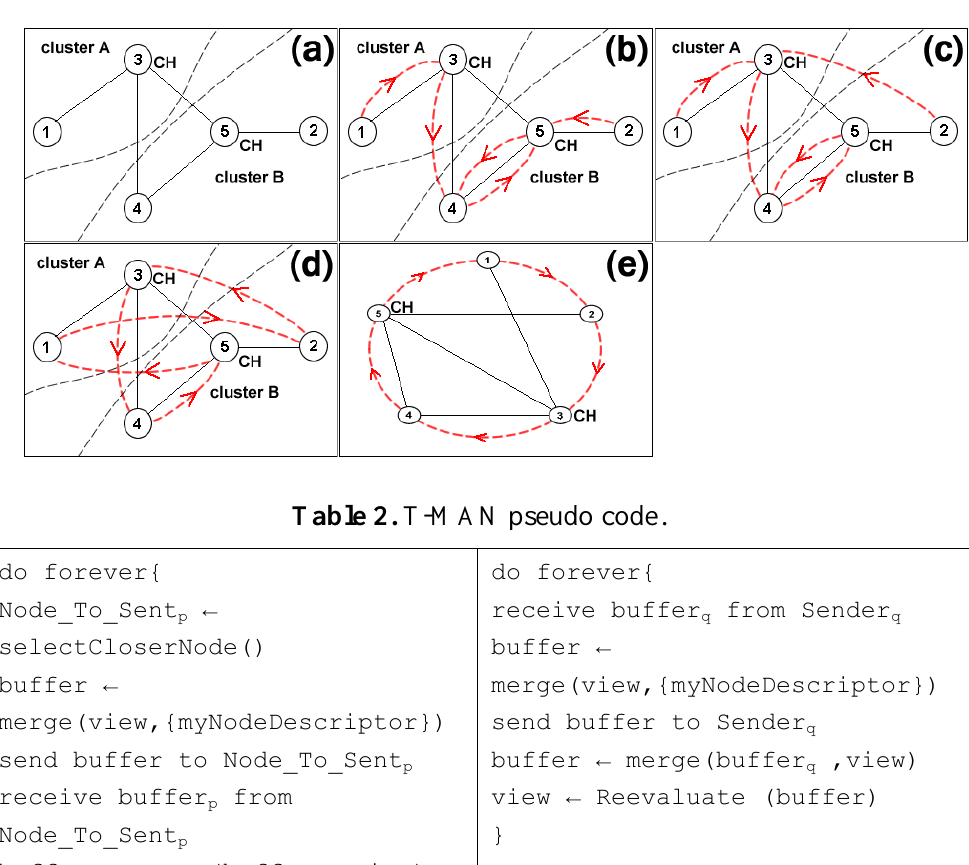
Figure 6. Topology Formulation Algorithm.